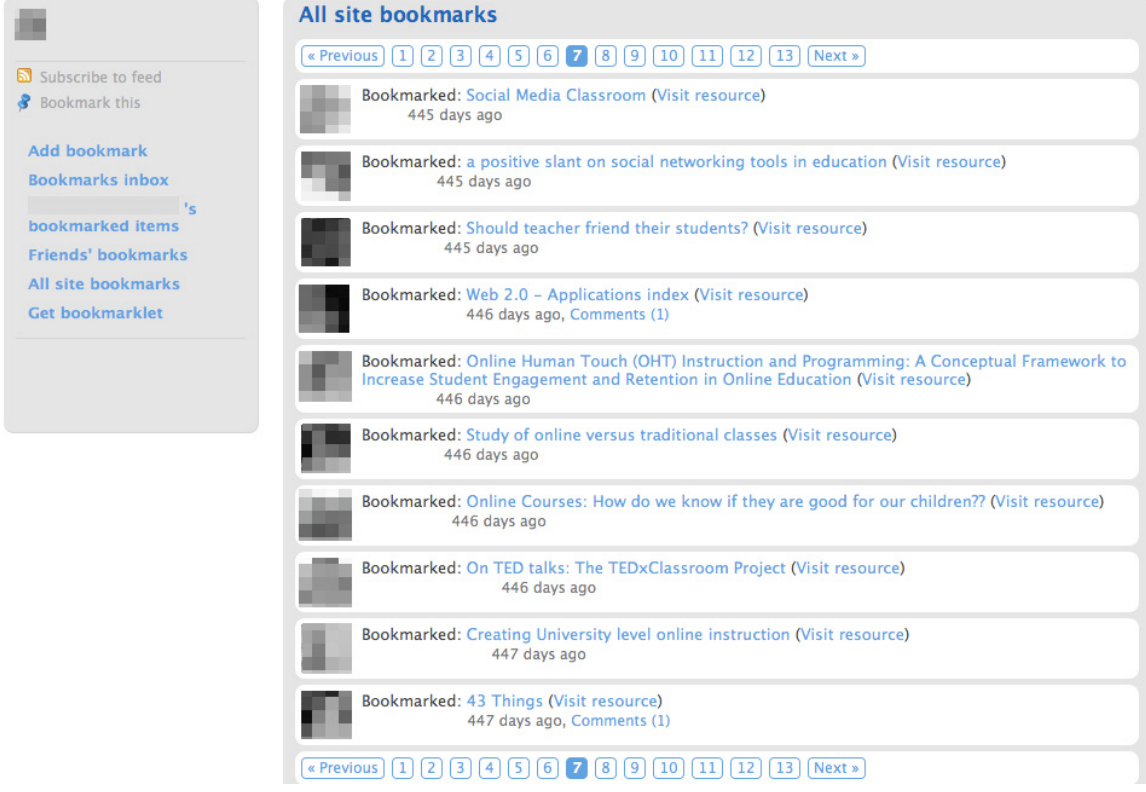
Figure 4 . User bookmarks